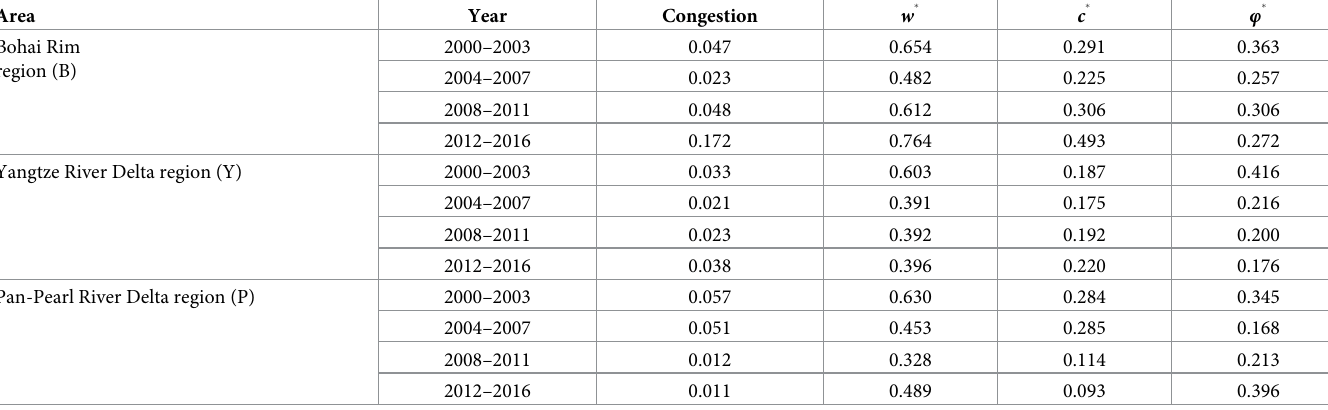
Table 5. Congestion and inefficiency decomposition in China’s three coastal regions.